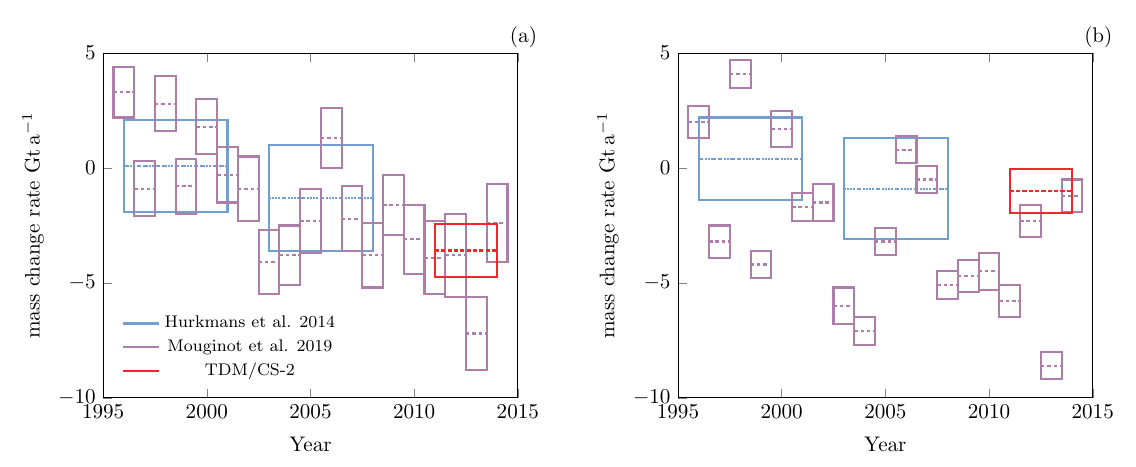
Figure 6. Comparison of mass balance results of the TDM/CS-2 combination with the volumetric approach of Hurkmans et al. [10] and the mass-budget method by Mouginot et al. [14] for individual glacier basins of ( a ) Zachariæ Isstrøm (ZI) and ( b ) Nioghalvfjerdsfjorden (79North).